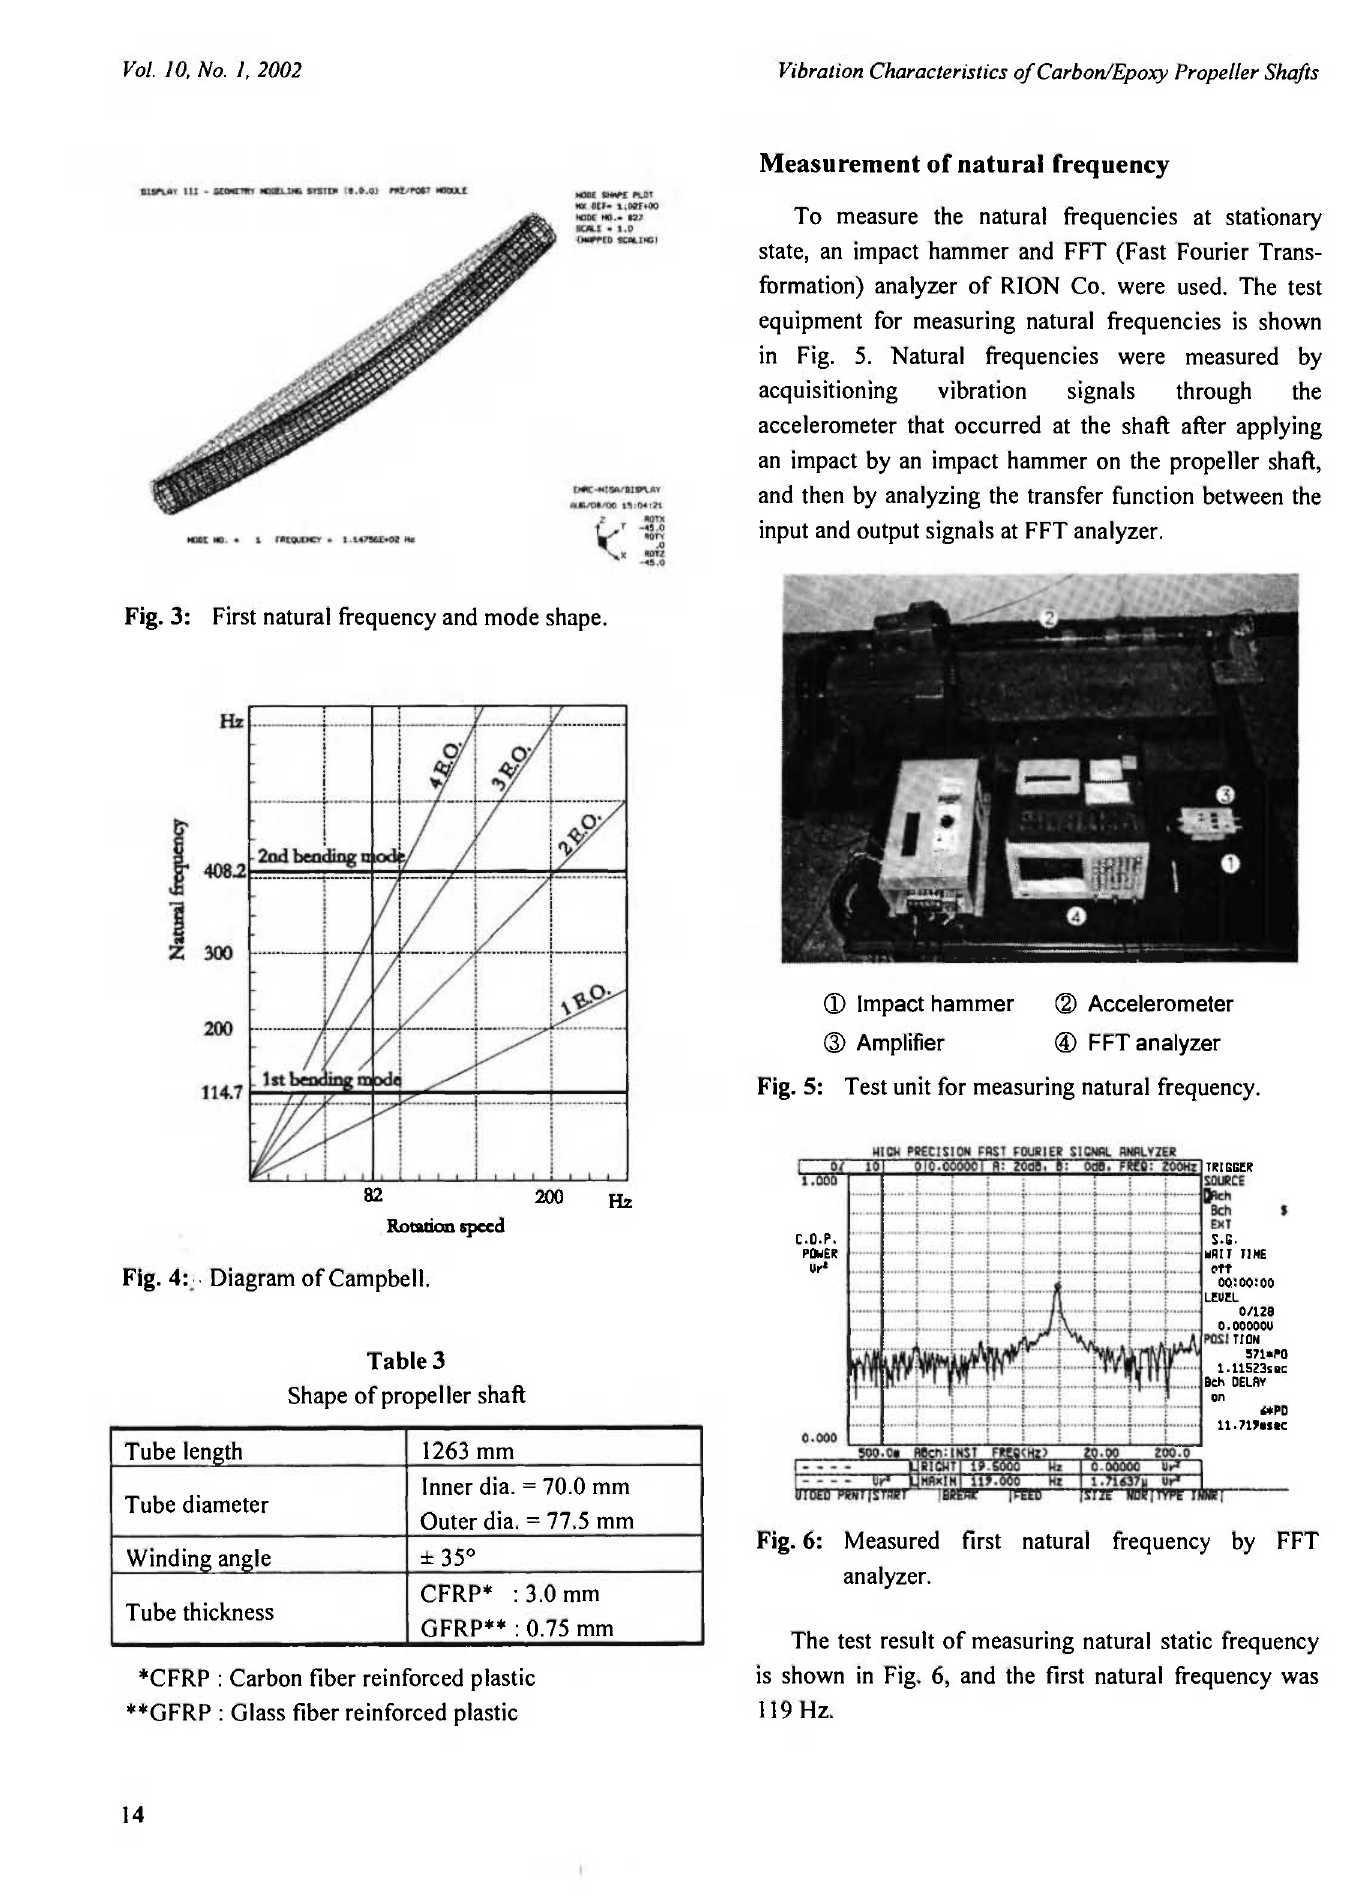
Shape of propeller shaft